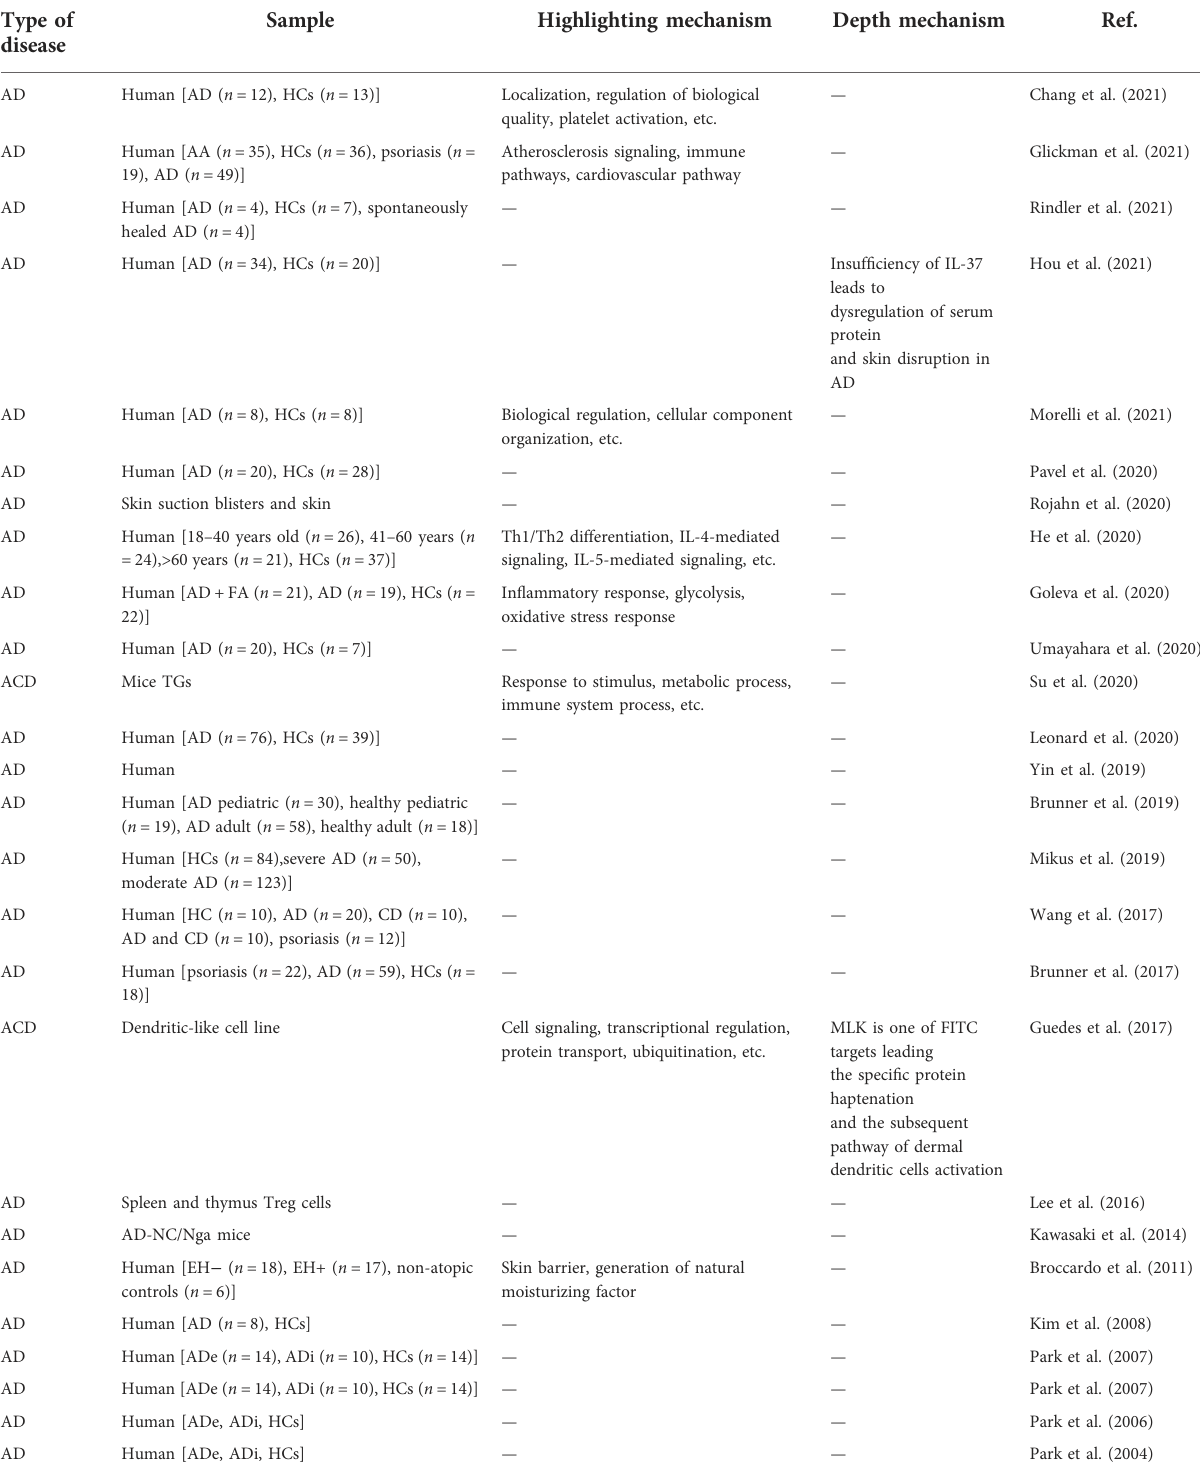
TABLE 2 Mechanism of atopic dermatitis pathogenesis within proteomic